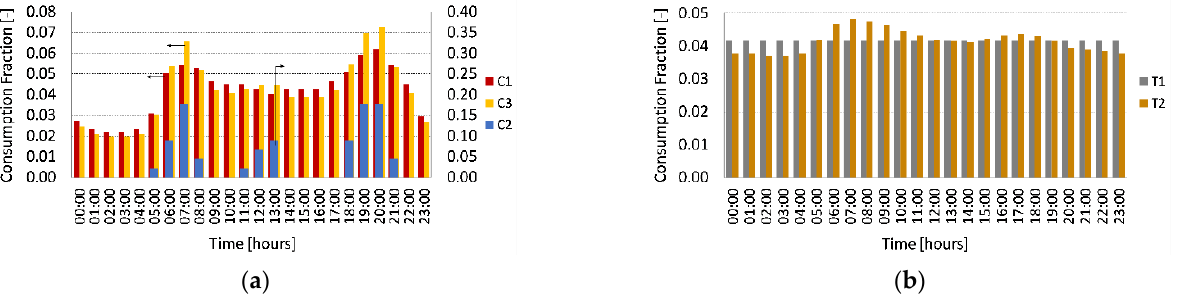
Figure 3. Daily gas consumption profiles for the residential and tertiary users ( a ) and industrial users ( b ) depending on the gas usage